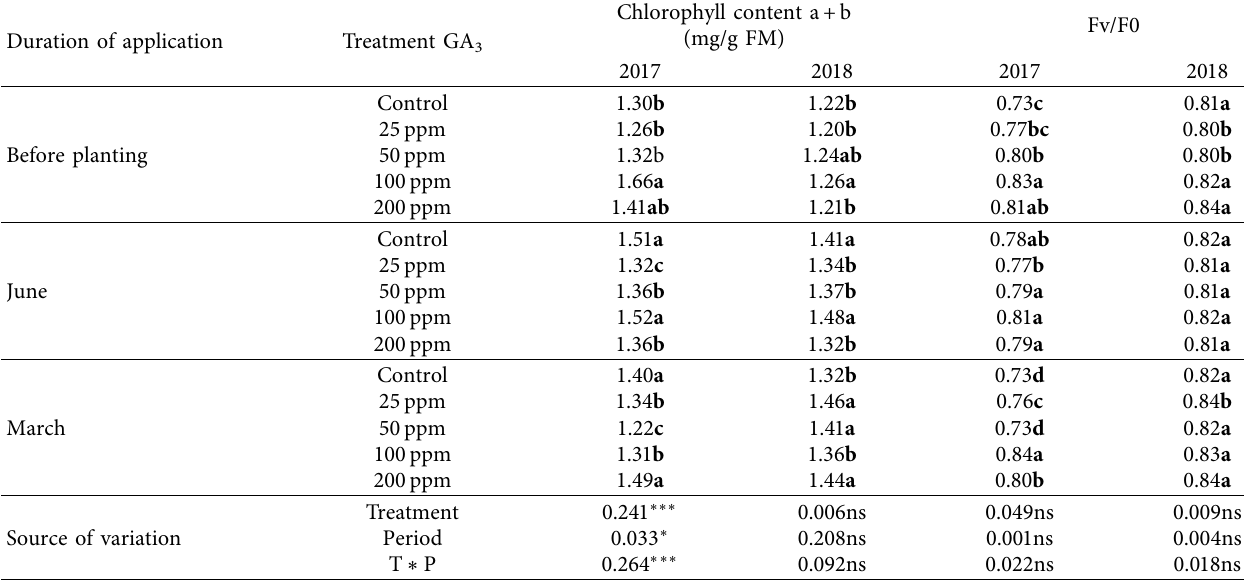
Table 5: Effect of different GA 3 concentrations and duration of application on total chlorophyll content (a+b) and Fv/F0 chlorophyll fluorescence. Values with the same letter in each application period in the column are not significantly different ( p � 0 . 05); ns: not significant; ∗ significant at 5%; ∗∗ significant at 1%, ∗∗∗ significant at 1‰. Duration of